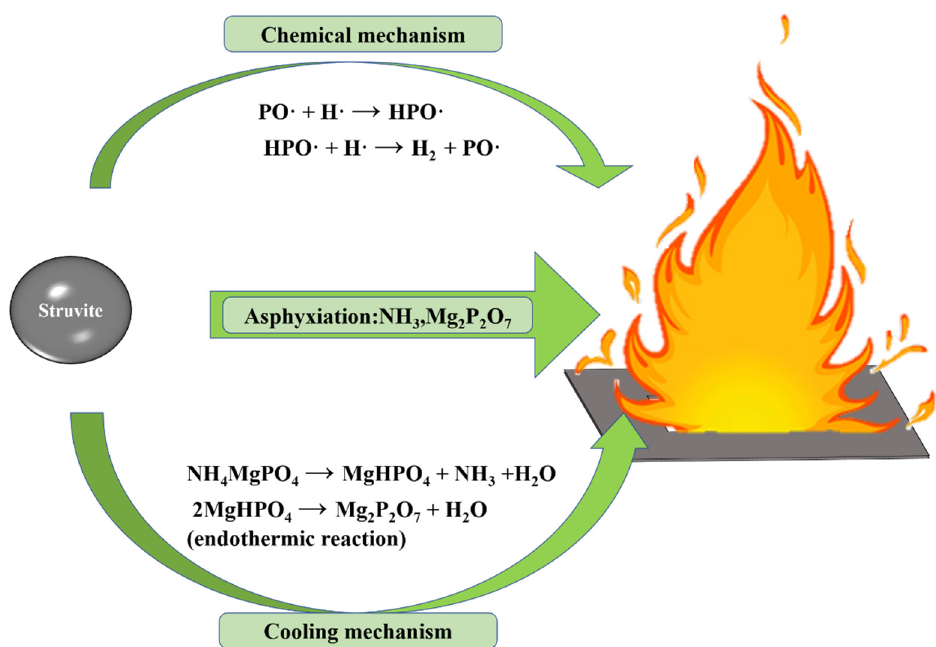
Figure 12. The fire-fighting mechanism of ultrafine struvite powder.